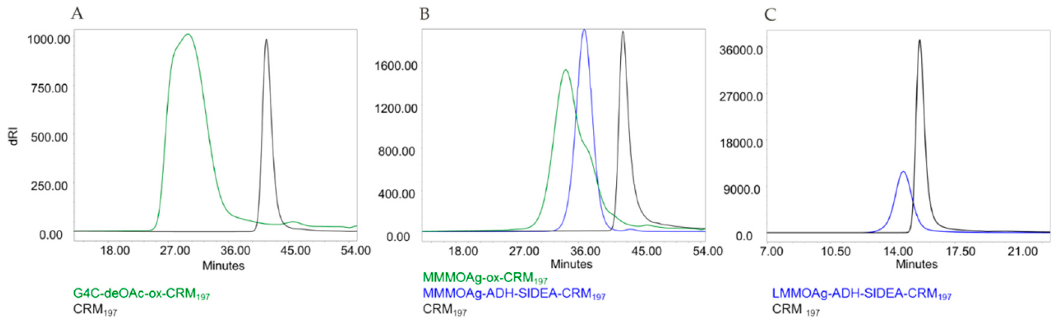
Figure 4. HPLC–SEC fluorescence emission profiles of G4C-ox-CRM 197 ( A ), MMMOAg-ox-CRM 197 and MMMOAg-ADH-SIDEA-CRM 197 ( B ), and LMMOAg-ADH-SIDEA-CRM 197 ( C ) compared to unconjugated CRM 197 . Table 4. Main characteristics of conjugates obtained with sugars of different lengths and by different chemistry.